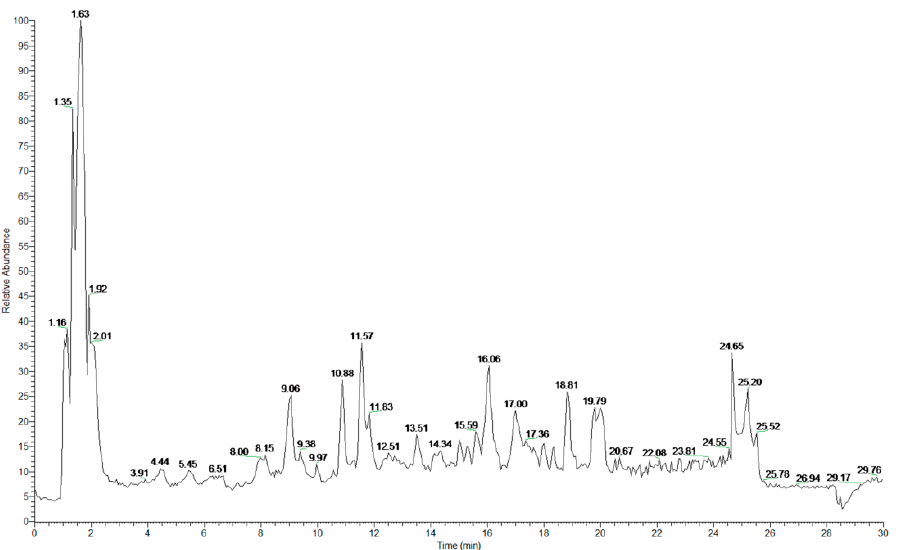
Figure 6. UPLC chromatographic separation of phenolic compounds from HBVN.